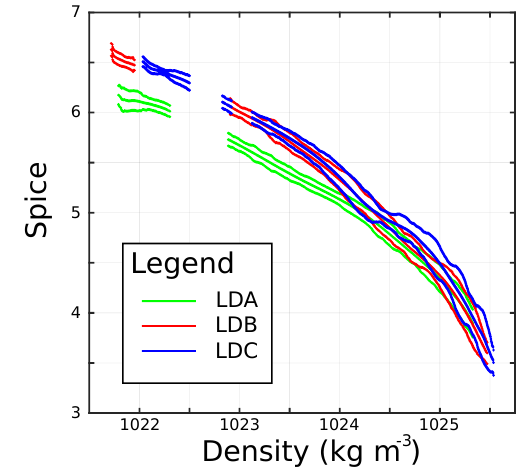
Figure 5. Statistical LD baseline of spice versus potential density for (a) LDA, (b) LDC, and (c) LDC. Mean values plotted in between envelope of ± 2 S Err obs